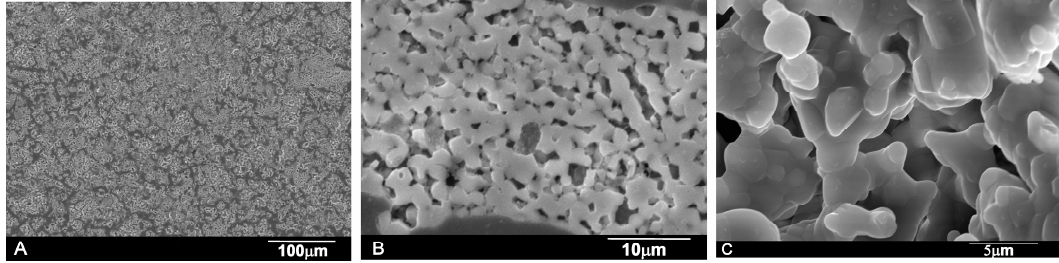
Figure 2. SEM images that depict ( A , B ) the polished Nurse’s A ceramic microstructure; ( C ) Fracture surface at a high magnification.